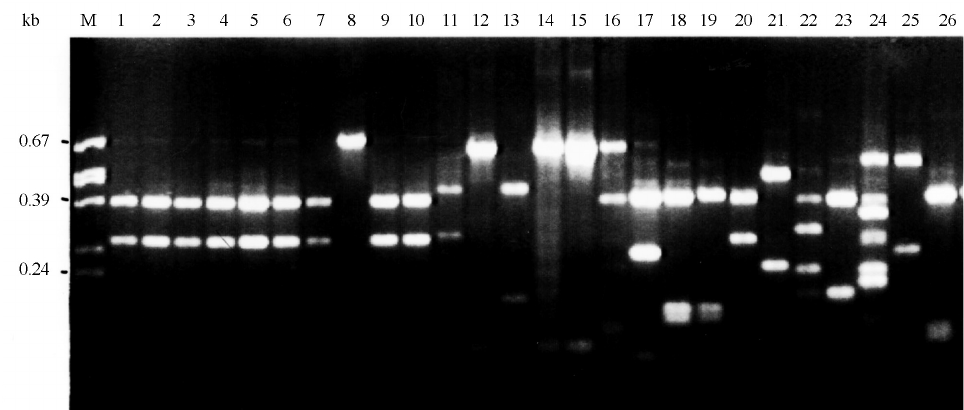
Figure 2 - Gel electrophoresis of the amplified rDNA internal transcribed sequence (ITS) region of 26 ectomycorrhizal fungal isolates digested with the Alu I restriction enzyme. Lanes are numbered according to the isolate identification scheme given in Table I. Size markers (pUC 19 digested with Hin f I and Rsa I) are indicated by M.